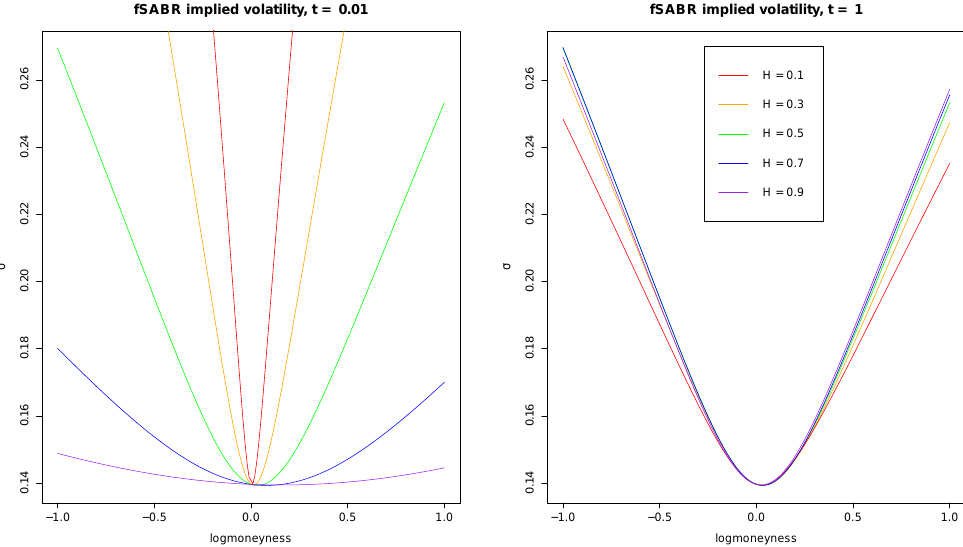
Figure 3. The implied volatility curves for t = 0.01 on the left , t = 1 on the right . Parameters are set as ρ = − 0.06867, ν = 0.5778, a 0 = 0.13927. H = 0.1 in red, H = 0.3 in orange, H = 1 H = 0.7 in blue, H = 0.9 in